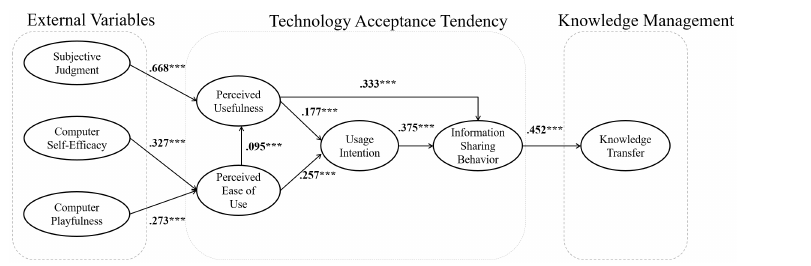
Fig 2. Path analysis results based on all valid samples (n = 779).